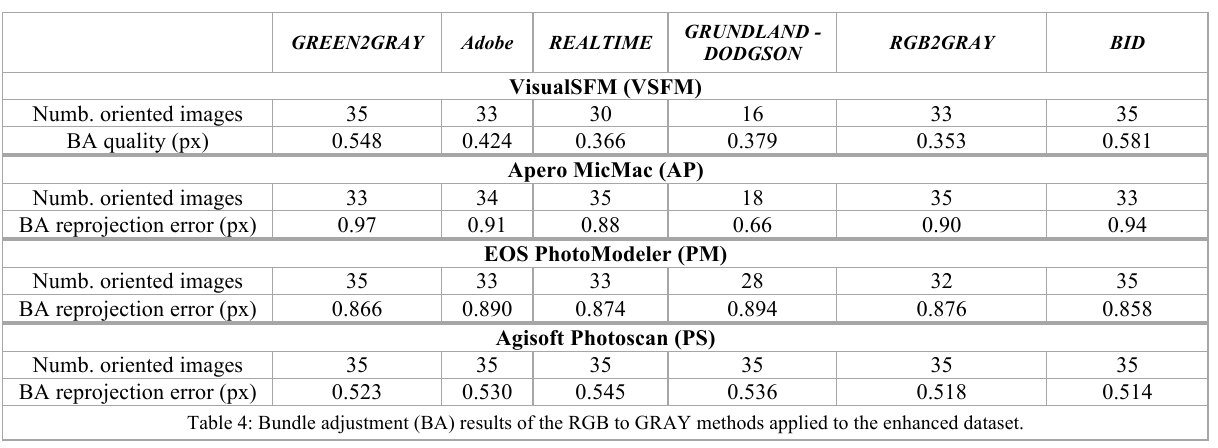
Numb. oriented images